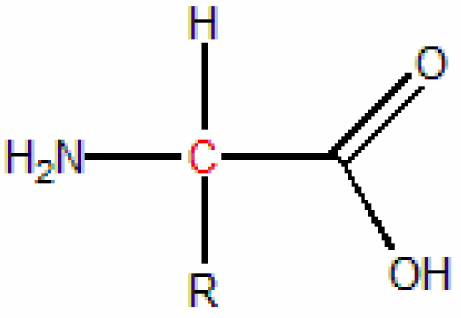
Figure 7. General structure formula of amino